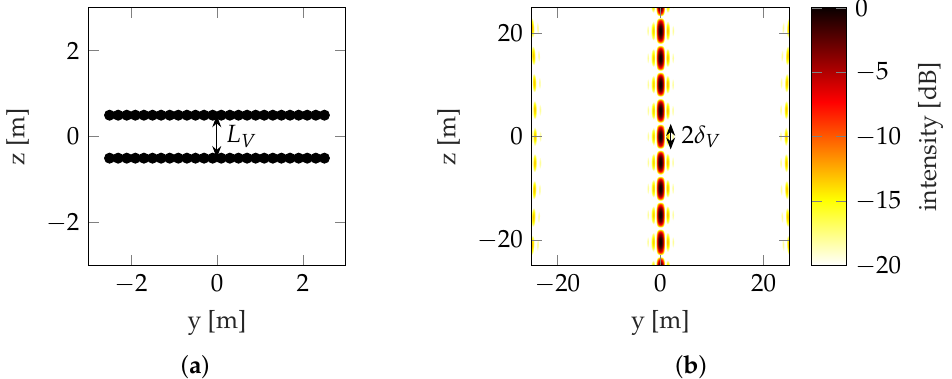
Figure 2. InSAR example: ( a ) Trajectory. ( b ) PSF. L V is the baseline and δ V is the vertical